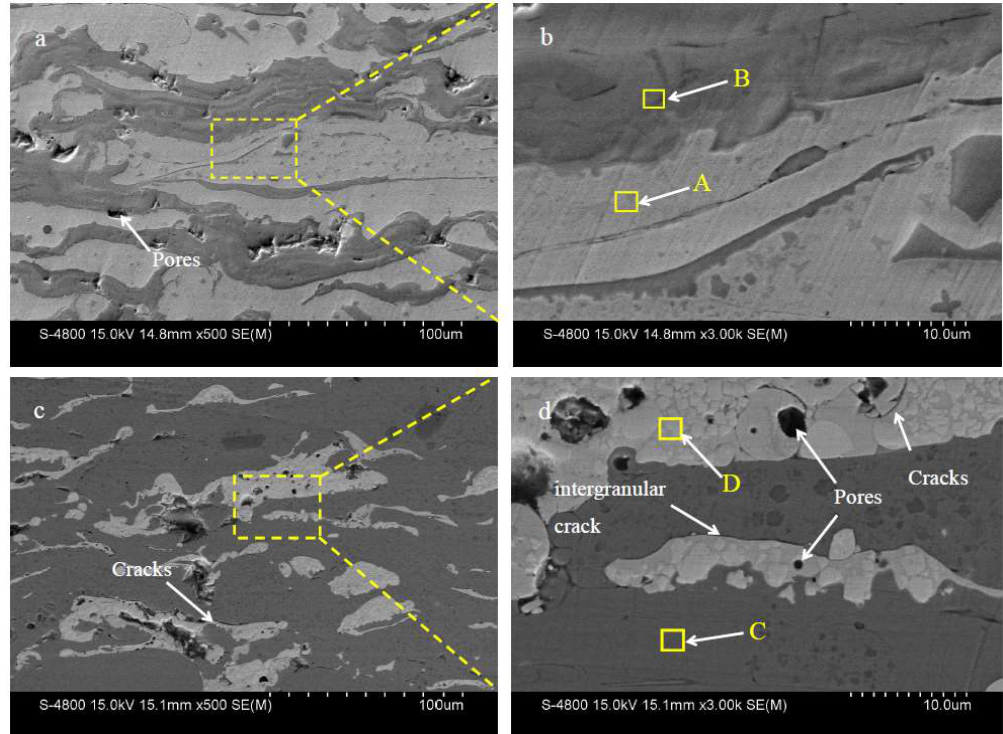
Table 2. EDS analysis results of different marked areas in Figure 3 (wt.%) .